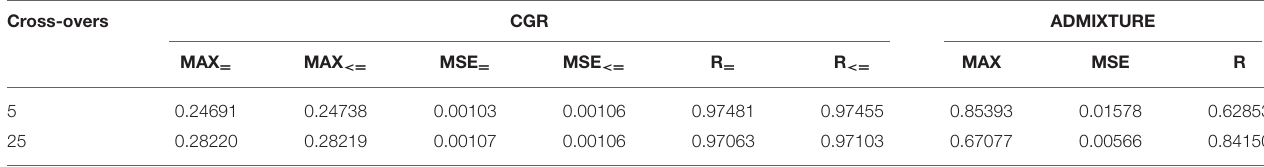
TABLE 3 | Statistic of the genome proportion estimation error for the cattle data set subject to the number of cross-overs when generating admixed animals for CGR and ADMIXTURE. Cross-overs CGR ADMIXTURE